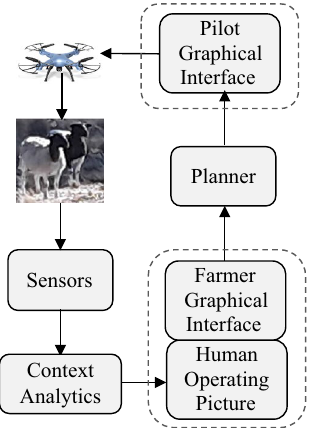
Figure 5. Sky shepherd human-autonomy team